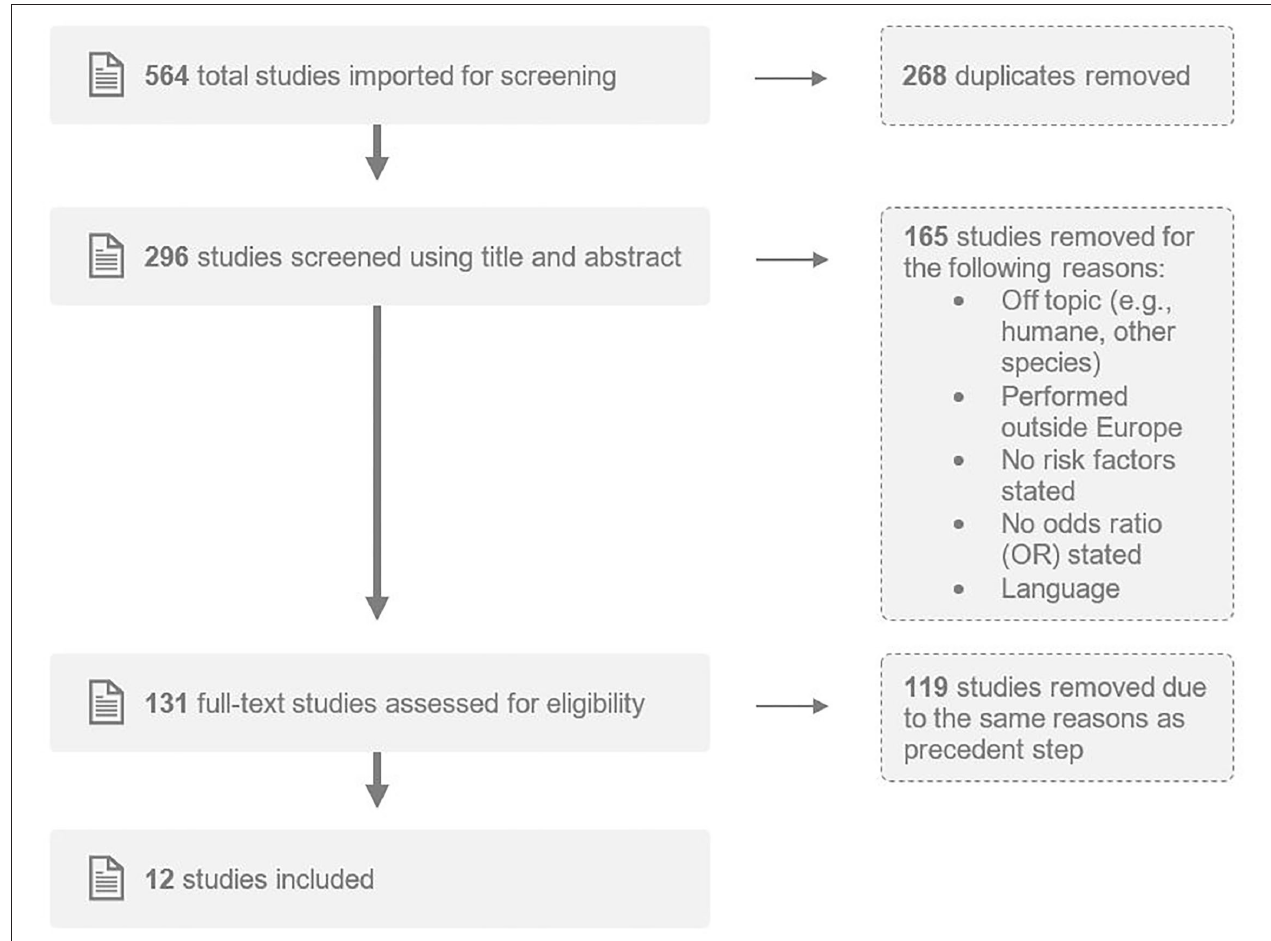
FIGURE 1 | Flow chart of studies through the selection process within the systematic review.